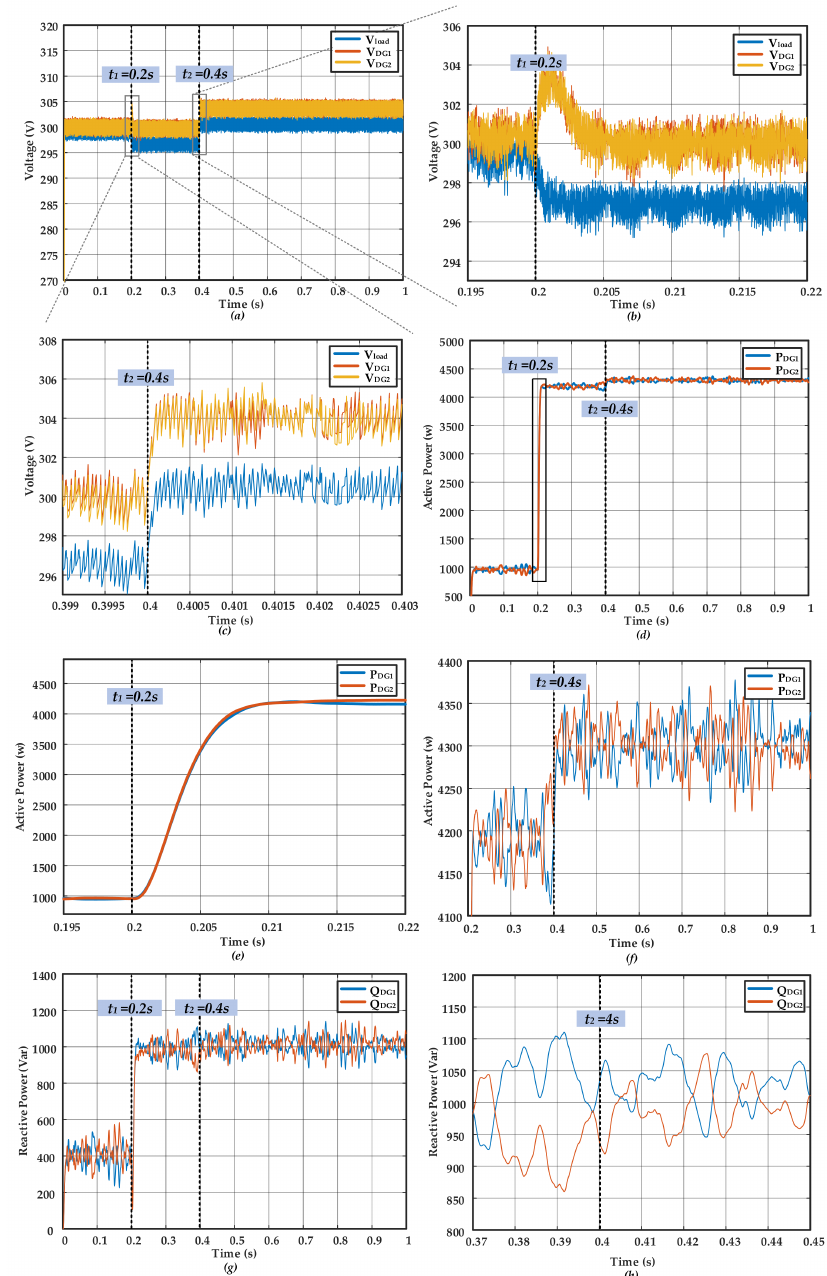
Figure 6. MATLAB/SIMULINK results with proposed control scheme. ( a ) Behavior of load voltage and inverter terminal voltages. ( b ) Disturbance load jX d 1 /R d 1 added at t 1 . ( c ) Voltage regulation with proposed control scheme. ( d ) Real power sharing. ( e , f ) Magnified active power. ( g ) Reactive power sharing. ( h ) Magnified reactive